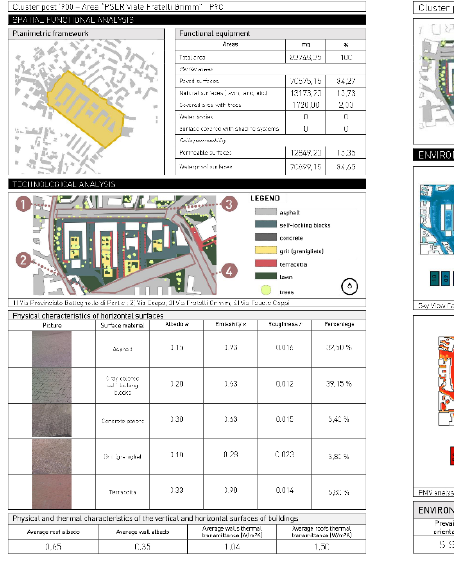
Figure 16. Registration of the TP9C test area with a light meta-design proposal: ( a ) technological analysis; ( b ) environmen- tal analysis; ( c ) CADI-BE output.